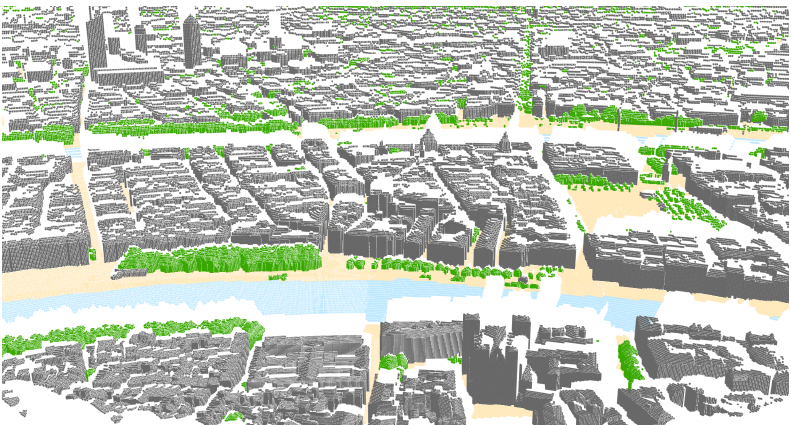
Figure 15. Three-dimensional visualization using our tools, with each color corresponding to the CityGML category of the resulting 3D points (green: vegetation, grey: buildings, yellow: terrain, blue: